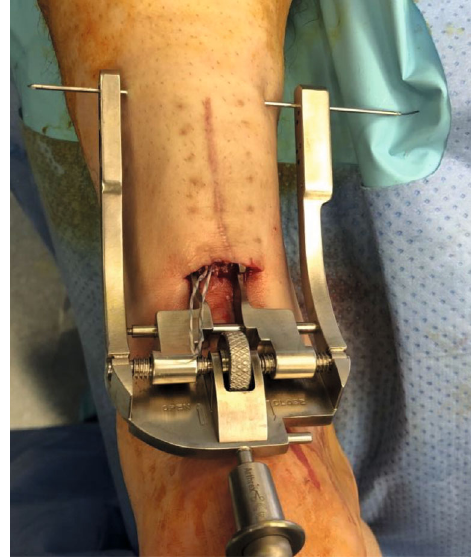
Figure 3: Revision surgical intervention utilizing minimally invasive jig to pass sutures through the proximal Achilles stump.